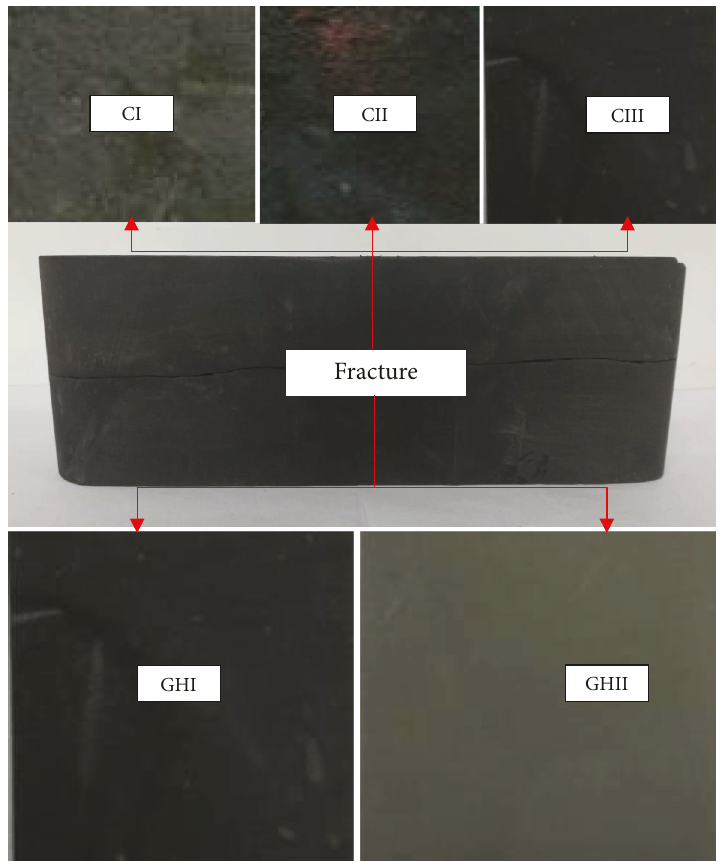
Figure 2: Surface characteristics of samples, four sets of test samples, and one group of steel samples (top